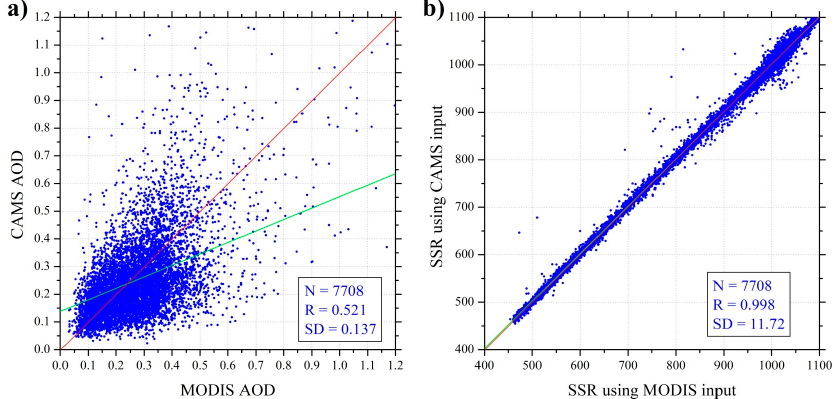
Figure 5. Scatterplots of ( a ) the CAMS forecasted AOD as compared to the MODIS observed values and ( b ) the SENSE simulated surface solar radiation (SSR) using as input the CAMS forecasted AOD